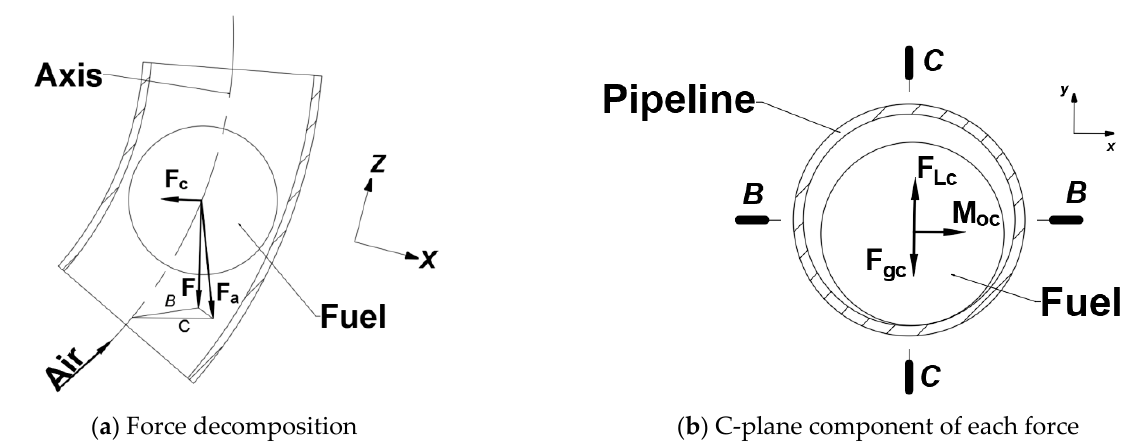
Figure 4. Force on the fuel element in an atypical bend.